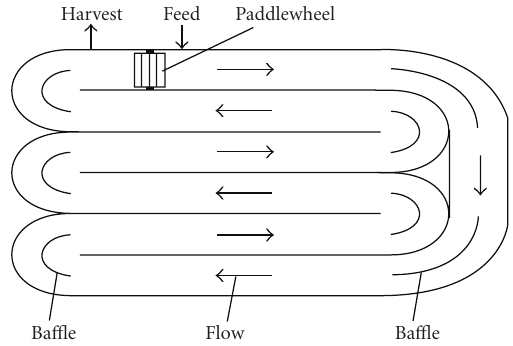
Figure 2: Raceway pond for open-air microalgae cultivation, ex- tracted from